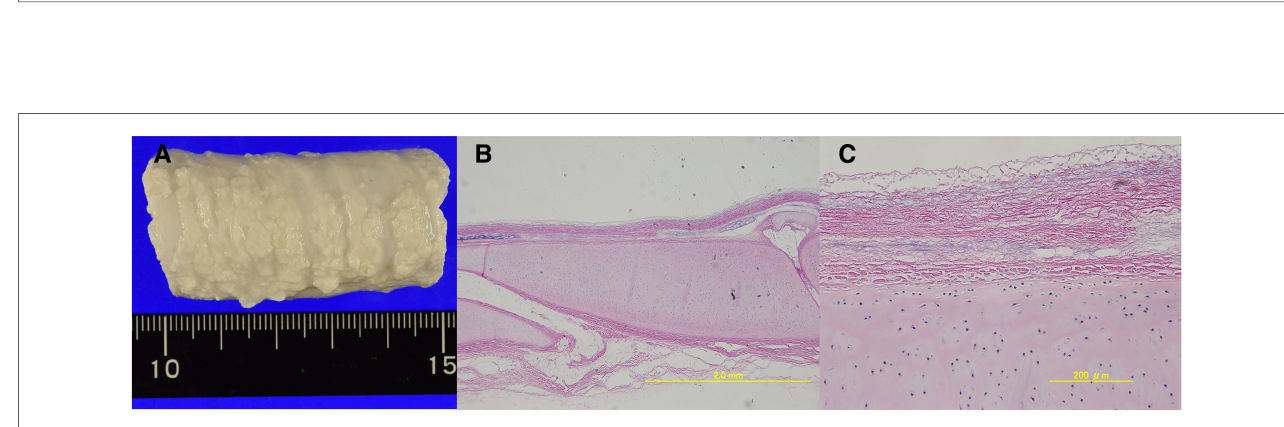
FIGURE 4 ( A ) Macroscopic view of the extracellular matrix (ECM) created using 17 detergent-enzymatic method cycles. ( B ) Microscopic view (4×) of hematoxylin and eosin histologic transversal sections. at fi rst glance, decellularized porcine trachea appears similar to native trachea. ( C ) Microscopic view (20×) shows removal of tracheal epithelial cells and glands in the ECM. Furthermore, the nuclei of the chondrocytes remained within the cartilage rings, but their cell walls had